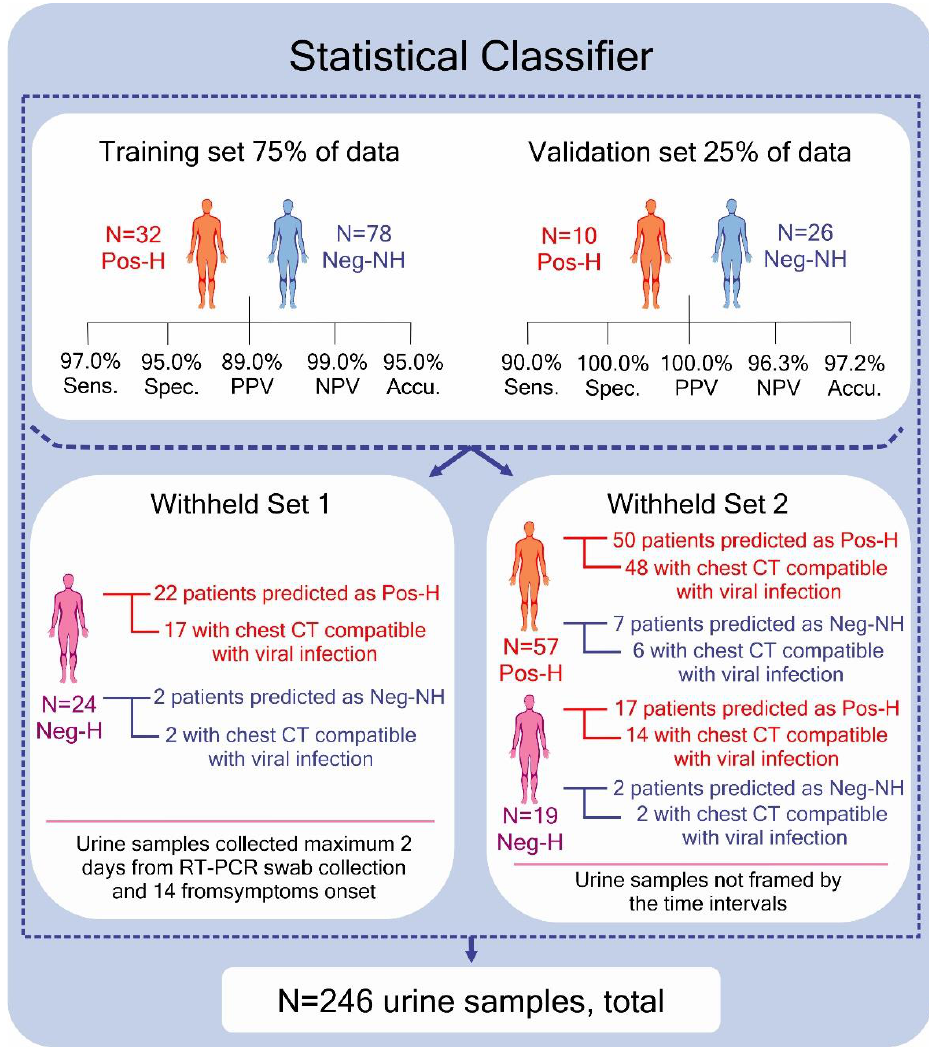
Figure 1. The statistical classifier’s experimental design and performance when identifying healthy non-hospitalized COVID-19 PCR-negative (Neg-NH) volunteers or hospitalized COVID-19 PCR- positive (Pos-H) patients. The Withheld Set 1 was composed of suspected hospitalized/symptomatic COVID-19 PCR-negative (Neg-H) patients. In contrast, the Withheld Set 2 was composed of Pos-H and Neg-H patients who did not meet the time frame criteria.